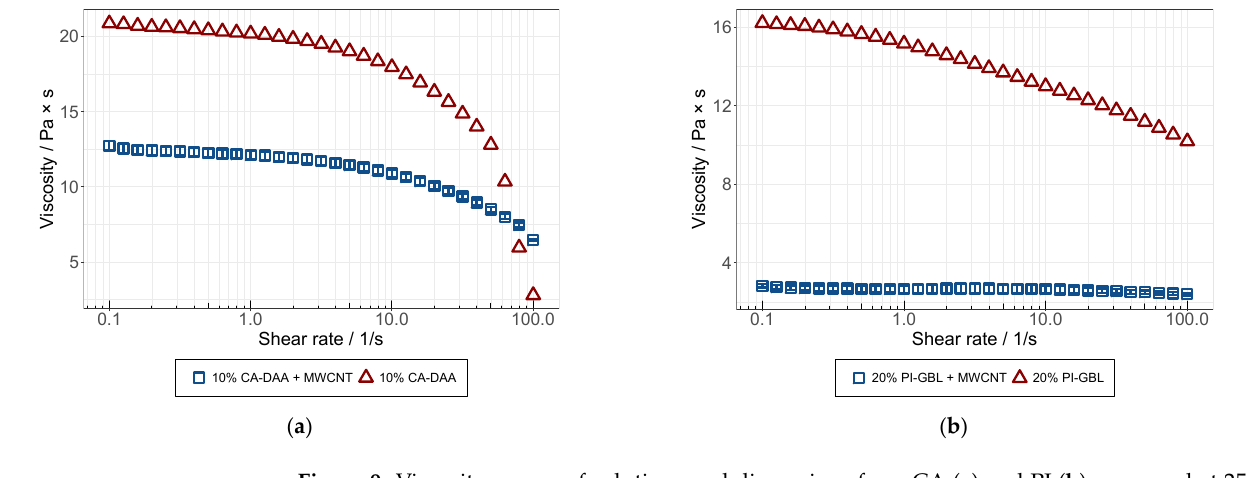
Figure 9. Viscosity curves of solutions and dispersions from CA ( a ) and PI ( b ) measured at 25 °C with plate-plate configuration rheometer.